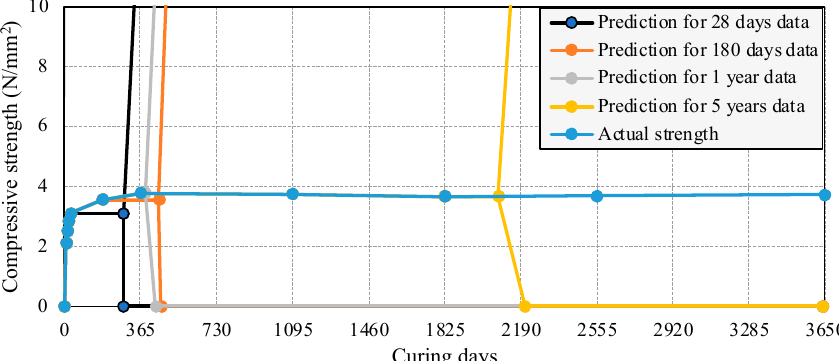
Figure 5. Prediction results of the ARIMA model.